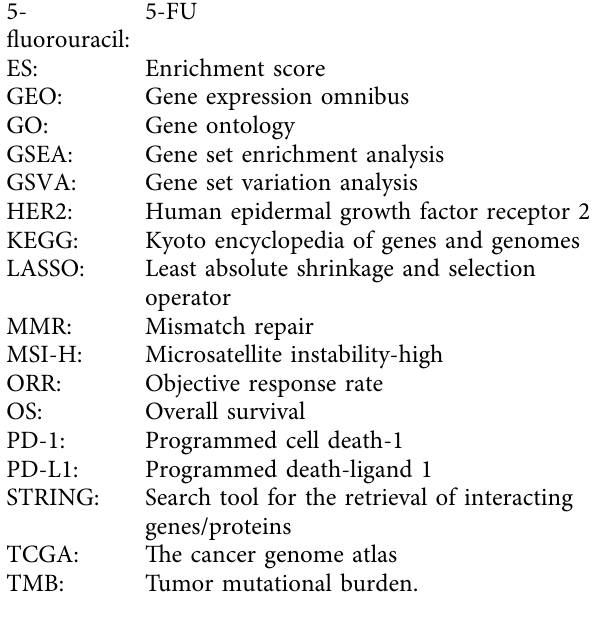
Figure S1. Visualization of enrichment score of gene sets in gastric cancer and adjacent nontumor tissues by gene set variation analysis. Figure S2. Establishment of subtypes of gastric cancer in the GEO cohort. (a). The optimal cutoff value of cluster was generated. (b). Visualization of cluster plot. (c). Survival patterns were drawn by survival analysis. (d) Silhouette plot was sketched. (e) Three clusters were identified. Figure S3. The protein-protein interaction net- work of genes in tumor gene set (a), (c), (e) and in normal gene set (b), (d), (f). Table S1. Correlation between clinical features and cancer subtypes. ( Supplementary Materials